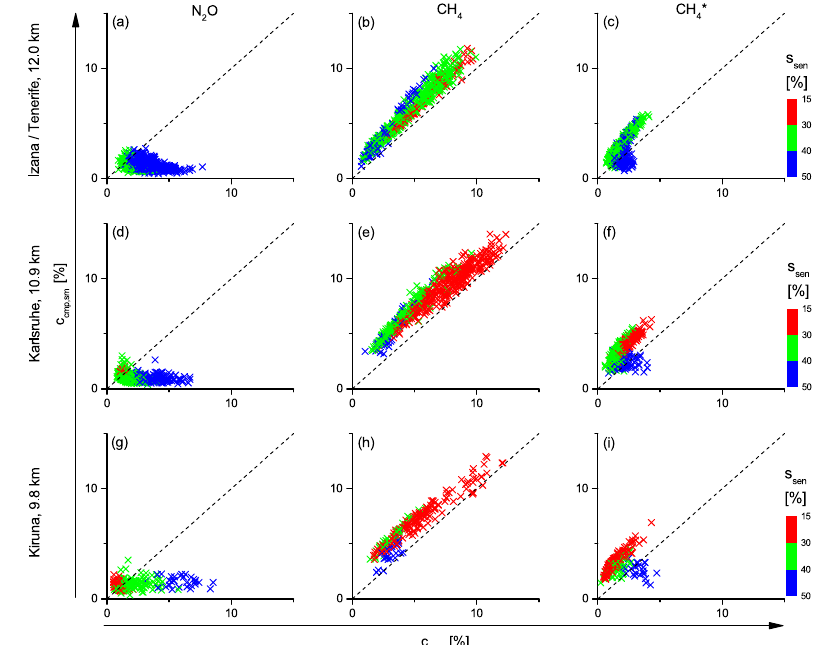
Figure D2. Same as Fig. D1 but for remote sensing data representing UTLS altitude